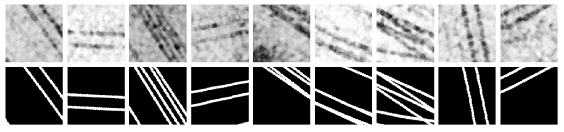
Figure 6. Exemplary training samples with all 5 data augmentation methods.